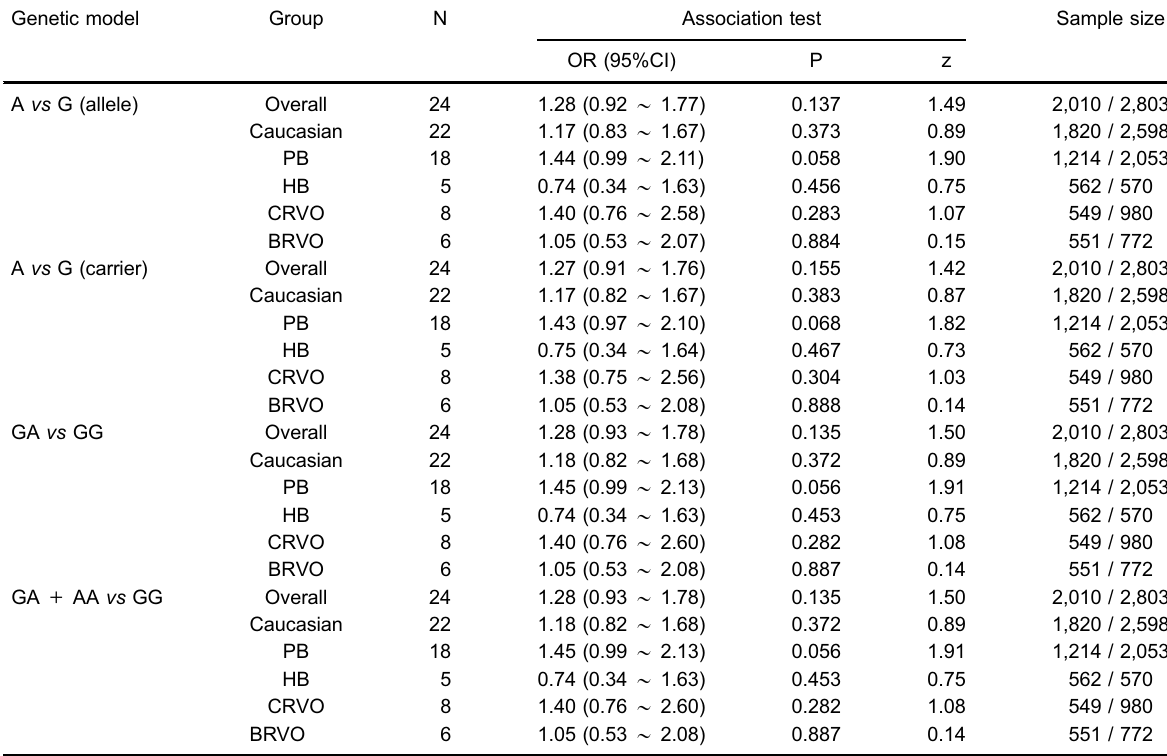
Table 2. Pooled analysis of the association between Prothrombin G20210A polymorphism and RVO risk. Genetic